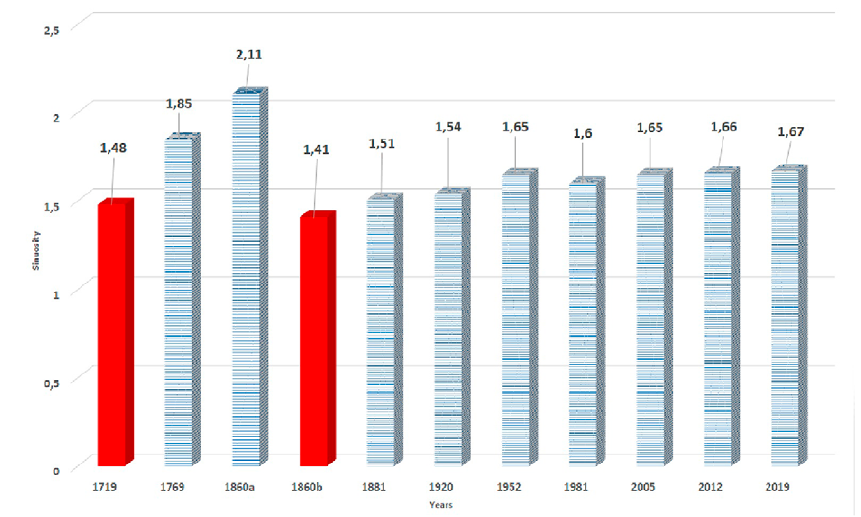
Figure 7. Sinuosity index evolution: 1860a-before incision; 1860b-after incision